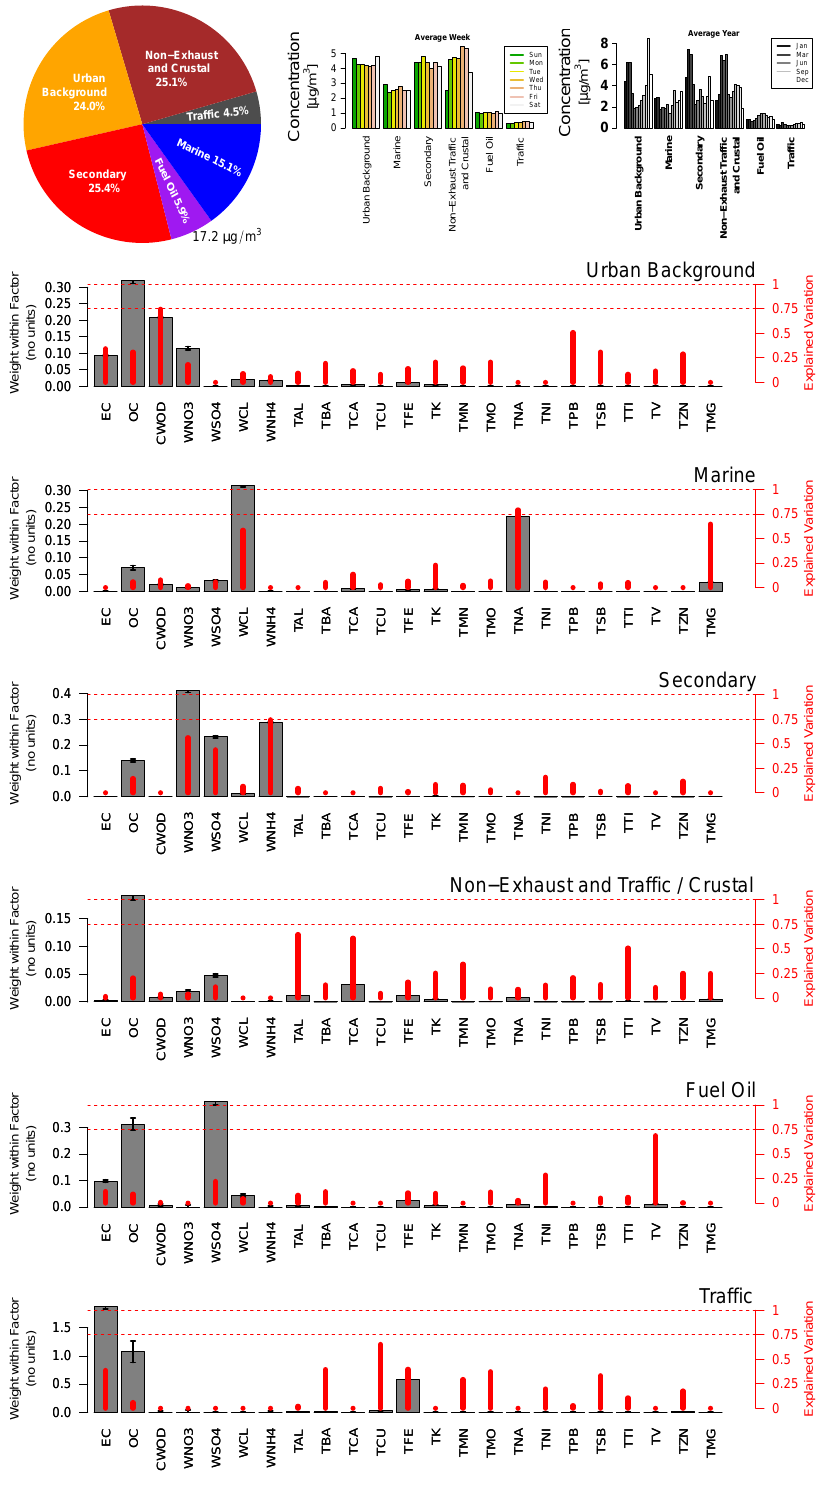
Figure 1. Factors outputted from PMF2 run on PM 10 mass composition data showing the contribution (grey bar) and explained variation of each metric (red